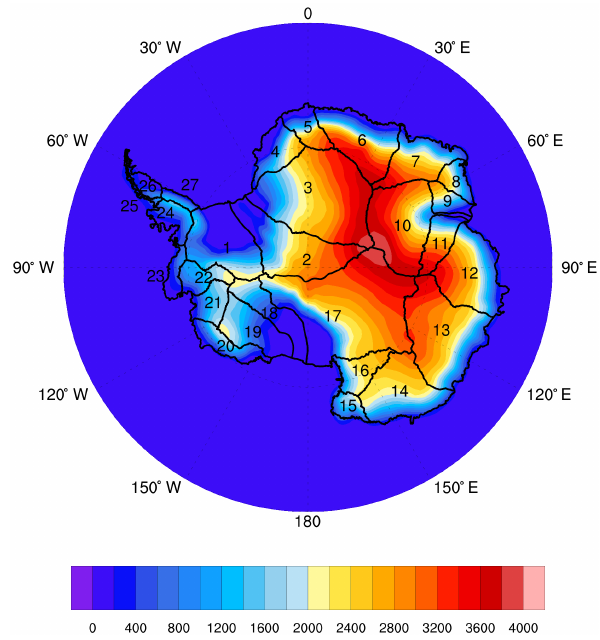
Figure 1. Colors: Antarctic Ice Sheet surface topography (meters). Outlines: numbered Antarctic Ice Sheet basins (Zwally et al.,